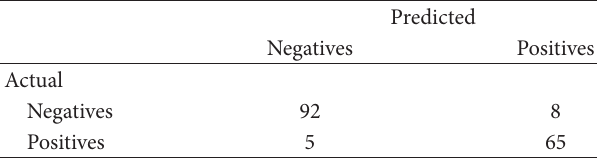
Table 5: The resultant confusion matrix for nipple detection.